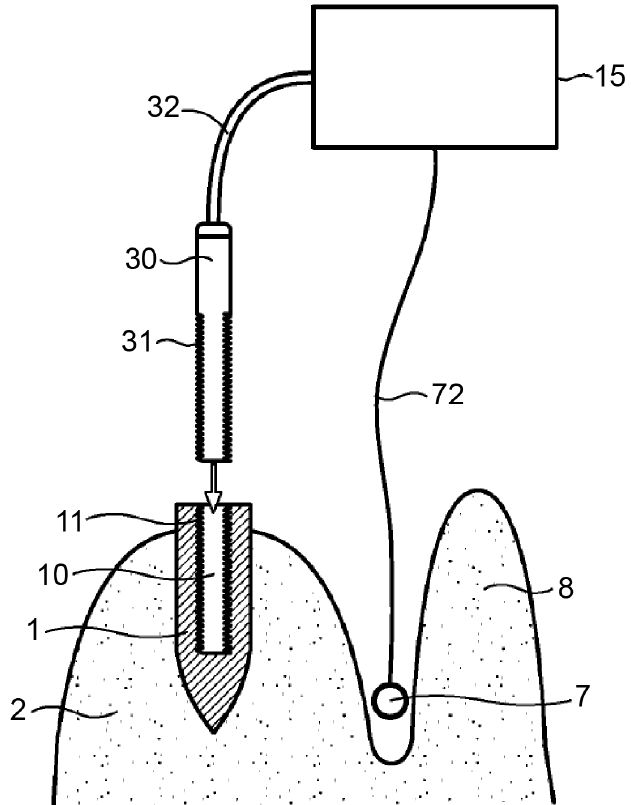
Figure 5. An alternative version of the invention contains an energy source (30) that can be inserted into the internal cavity of the implant. The control device (15) is connected via a sensor line (72) to a sensor (7), which can be placed between the jawbone (2) and the lip (8) in the vicinity of the dental implant (1) to be treated. Source: [49].